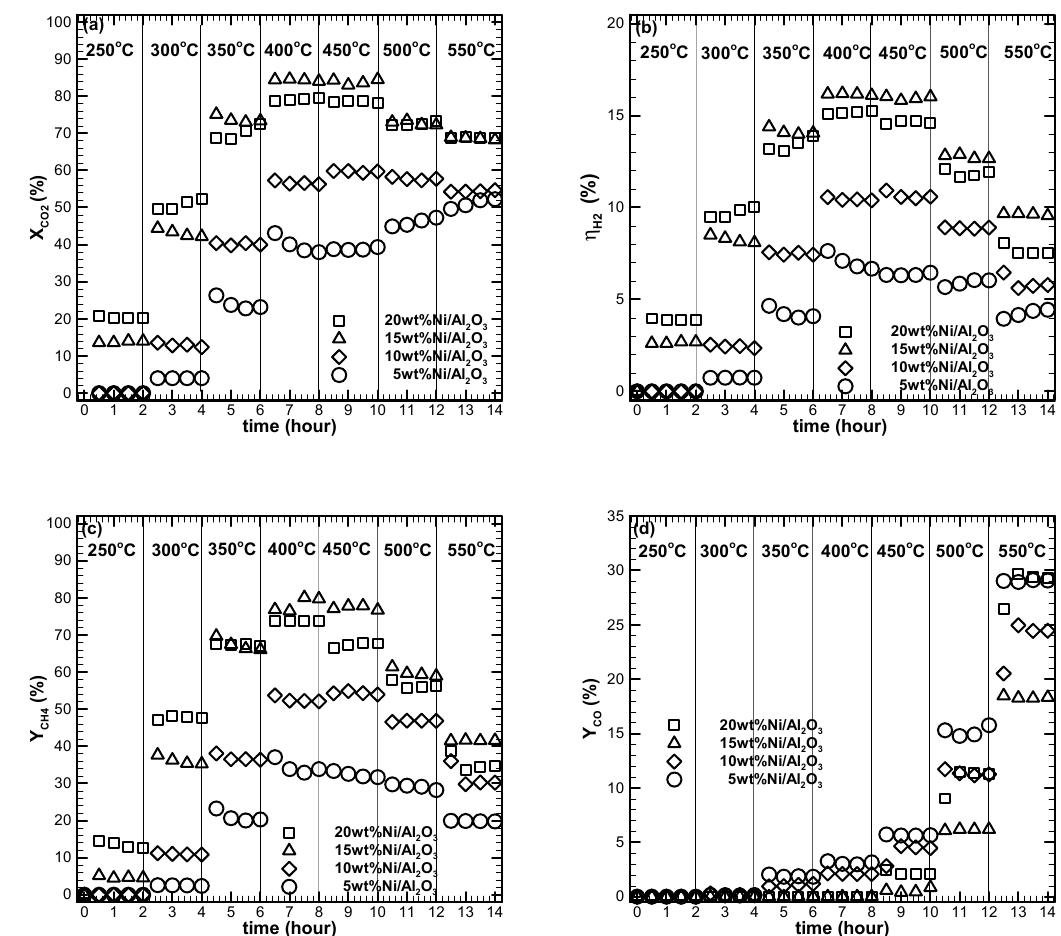
Figure 3. Time on stream measured CO 2 methanation performance as functions of the Ni loading and reaction temperature. ( a ) CO 2 conversion, ( b ) H 2 efficiency, ( c ) CH 4 yield, and ( d ) CO yield.